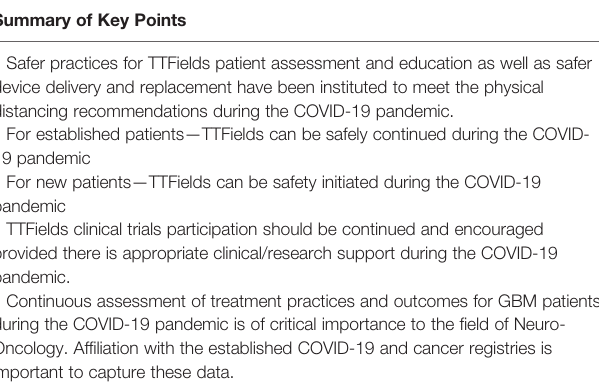
TABLE 1 | Summary of Key Points: Based on expert panel opinion. Summary of Key